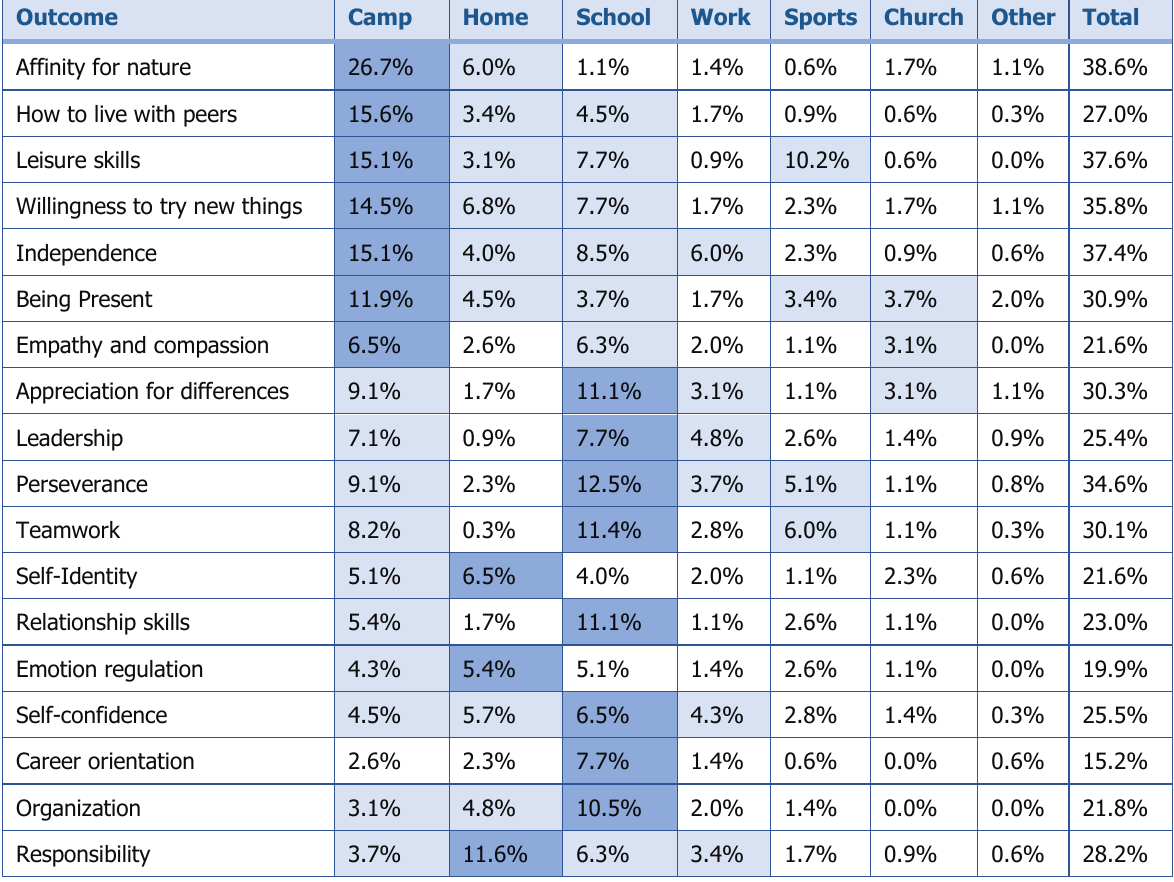
Table 4. Primary Learning Settings for Camp-Related